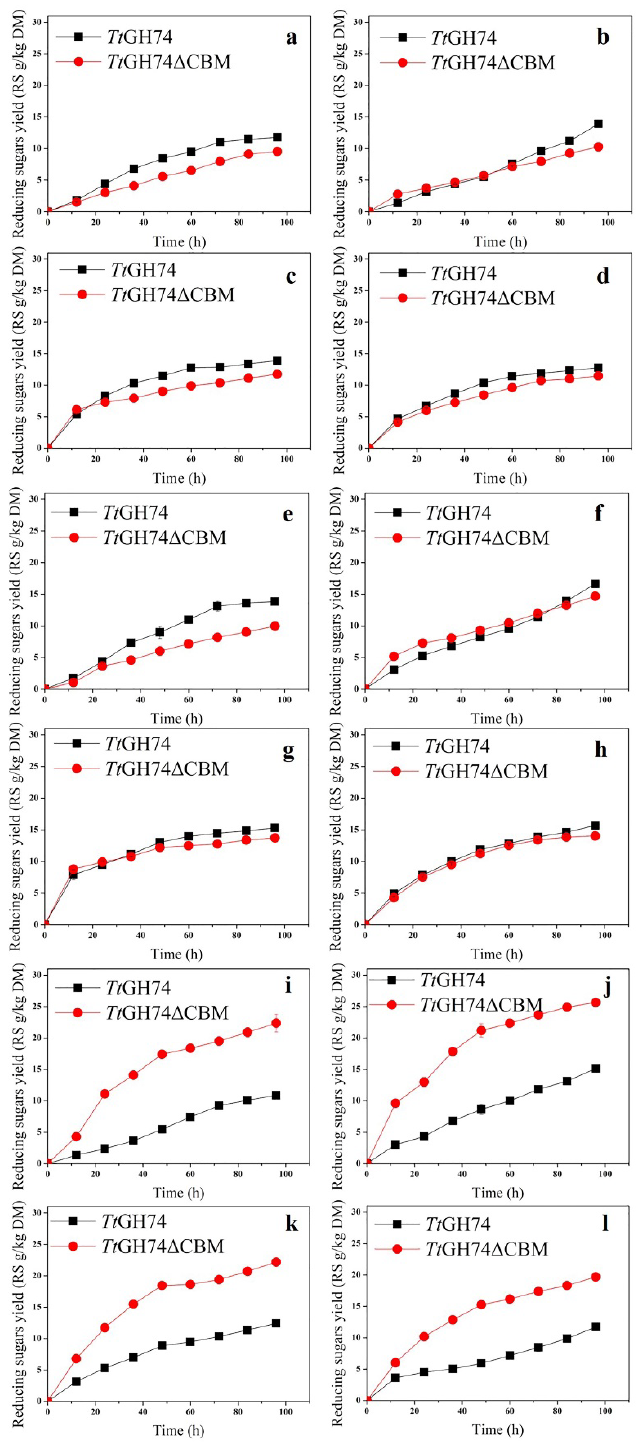
Figure 8. Time courses of the enzymatic hydrolysis of sulfuric-acid-pretreated corn bran, DES-pretreated corn bran and apple pomace by Tt GH74 or Tt GH74 ∆ CBM. ( a – d ): 10, 20, 40 and 80 mg of sulfuric-acid-pretreated corn bran, respectively; ( e – h ): 10, 20, 40 and 80 mg of DES-pretreated corn bran, respectively; ( i – l ): 10, 20, 40 and 80 mg of DES-pretreated apple pomace, respectively. The product yield was expressed in grams of reducing sugar produced by per kilogram of dry material (Reducing Sugars g/kg Dry Material, RS g/kg DM).